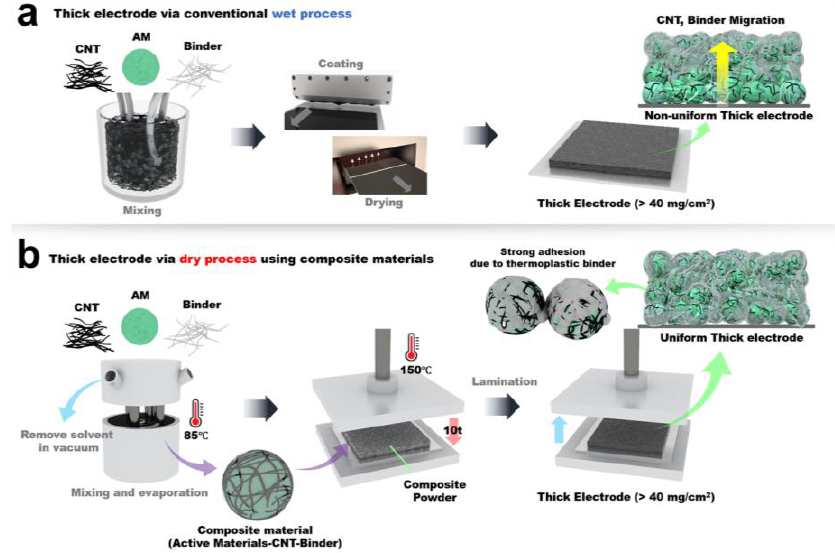
Figure 1. ( a ) Thick electrode produced via conventional wet processing, showing CNT and binder migration during drying; ( b ) Thick electrode produced via dry processing, using composite materials. AM: active materials; CNT: Carbon nano tube.